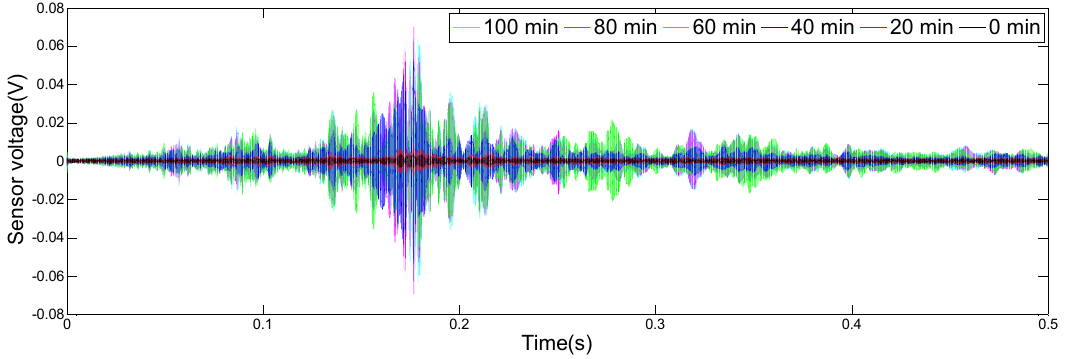
Figure 10. Signal received by SA1 (0–100 min).